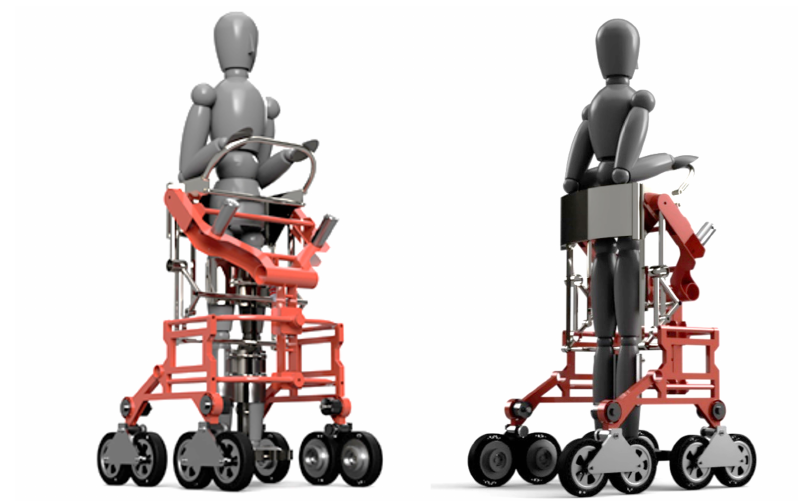
Figure 7. Model of the stabilizing mechanism. ( Left ) Coronal, ( Right ) Sagittal.